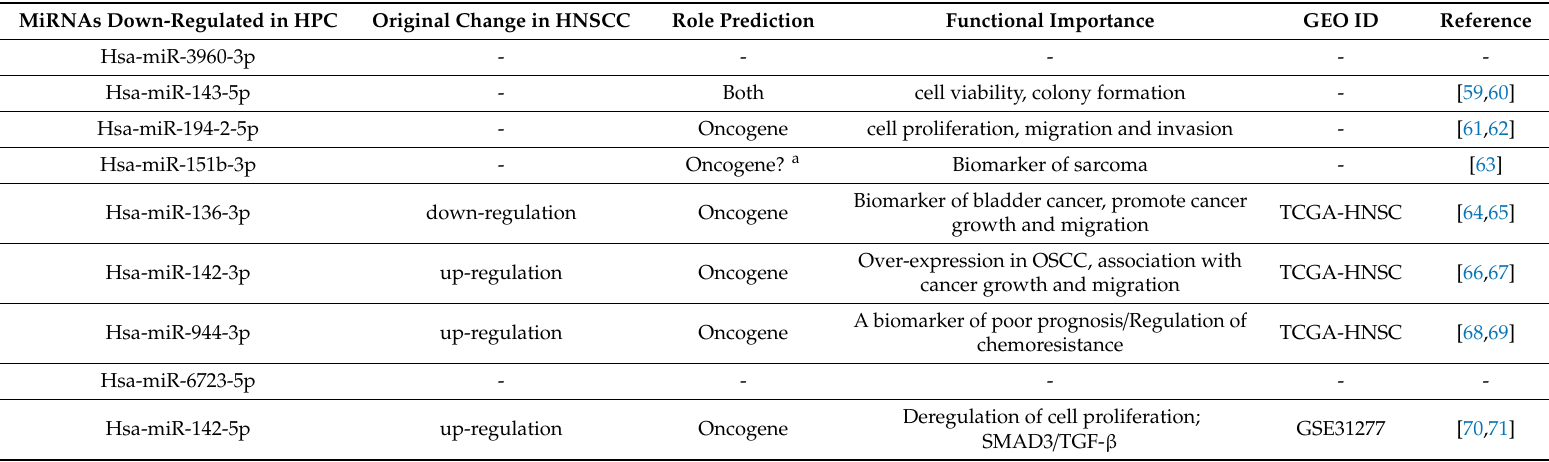
Table 3. Target prediction algorithm for microRNAs of human hypopharyngeal tumor model down-regulated by 188